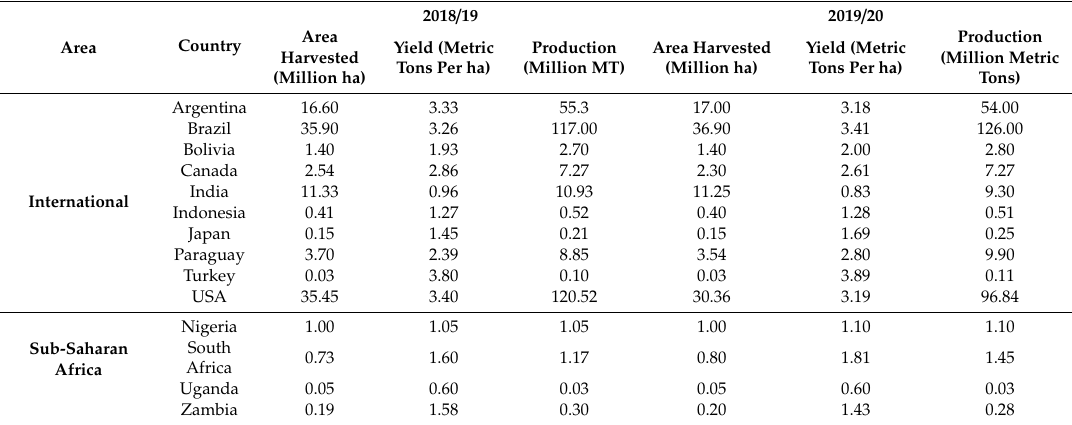
Table 1. Data regarding soybean production in the top sub-Saharan Africa countries and selected international countries from 2018 / 19 to projected data for 2019 / 20